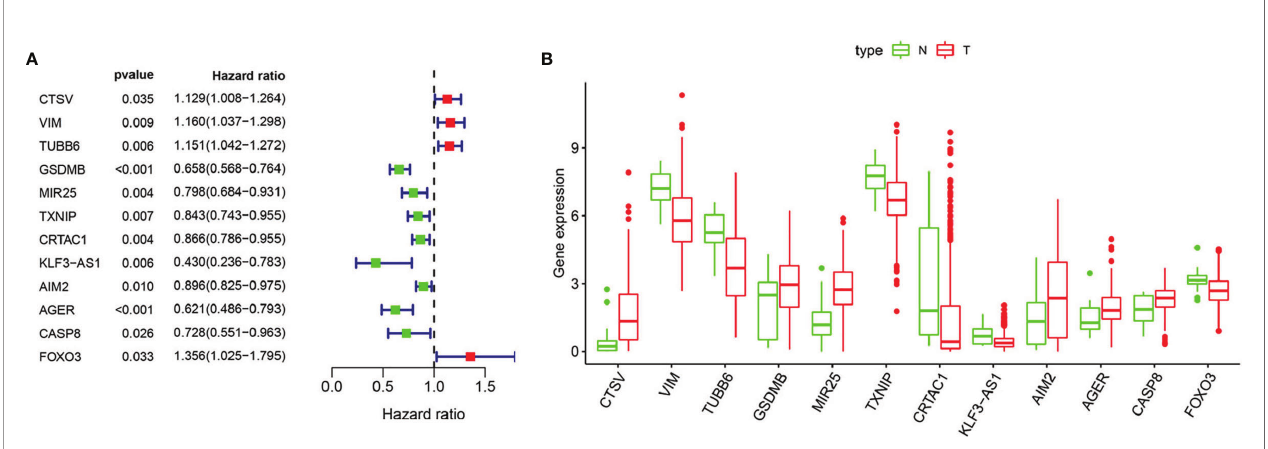
FIGURE 4 | Regression analysis to select pyroptosis genes related to prognosis of BLCA. (A) Forest map of pyroptosis genes analyzed by univariate cox regression. (B) Boxplot of pyroptosis genes analyzed by LASSO regression. “ N ” stands for “ Normal ” and “ T ” stands for “ Tumor ”